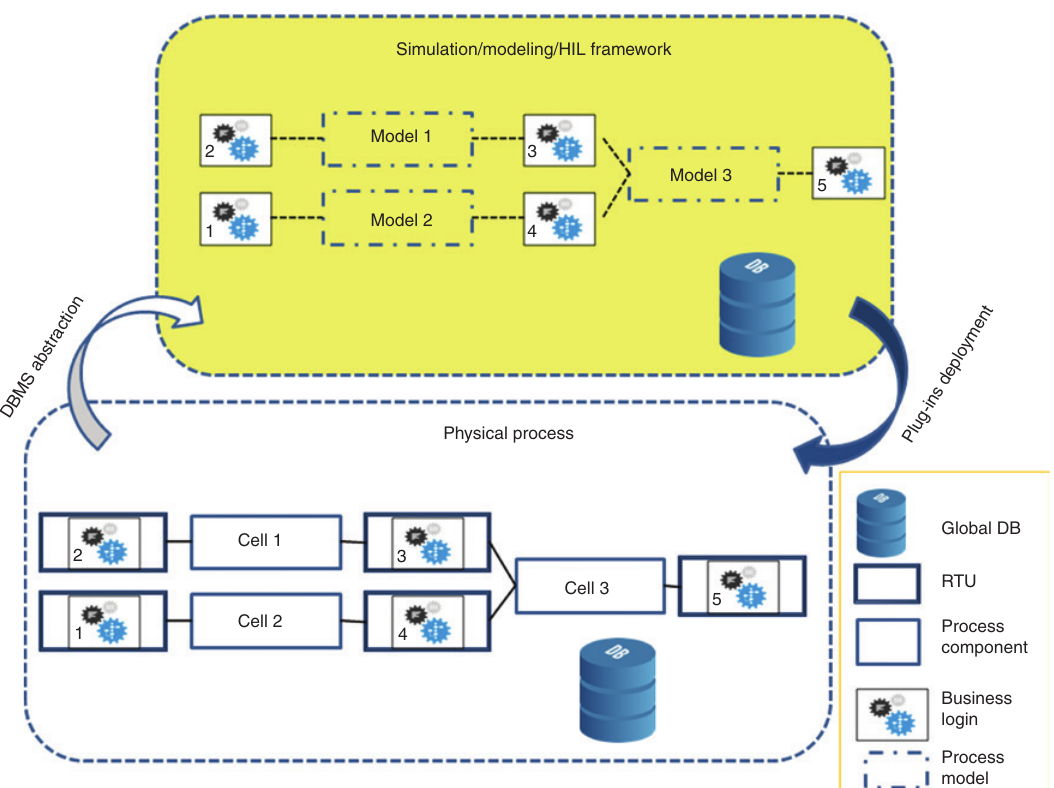
Figure 5: DBMS Abstraction and Development